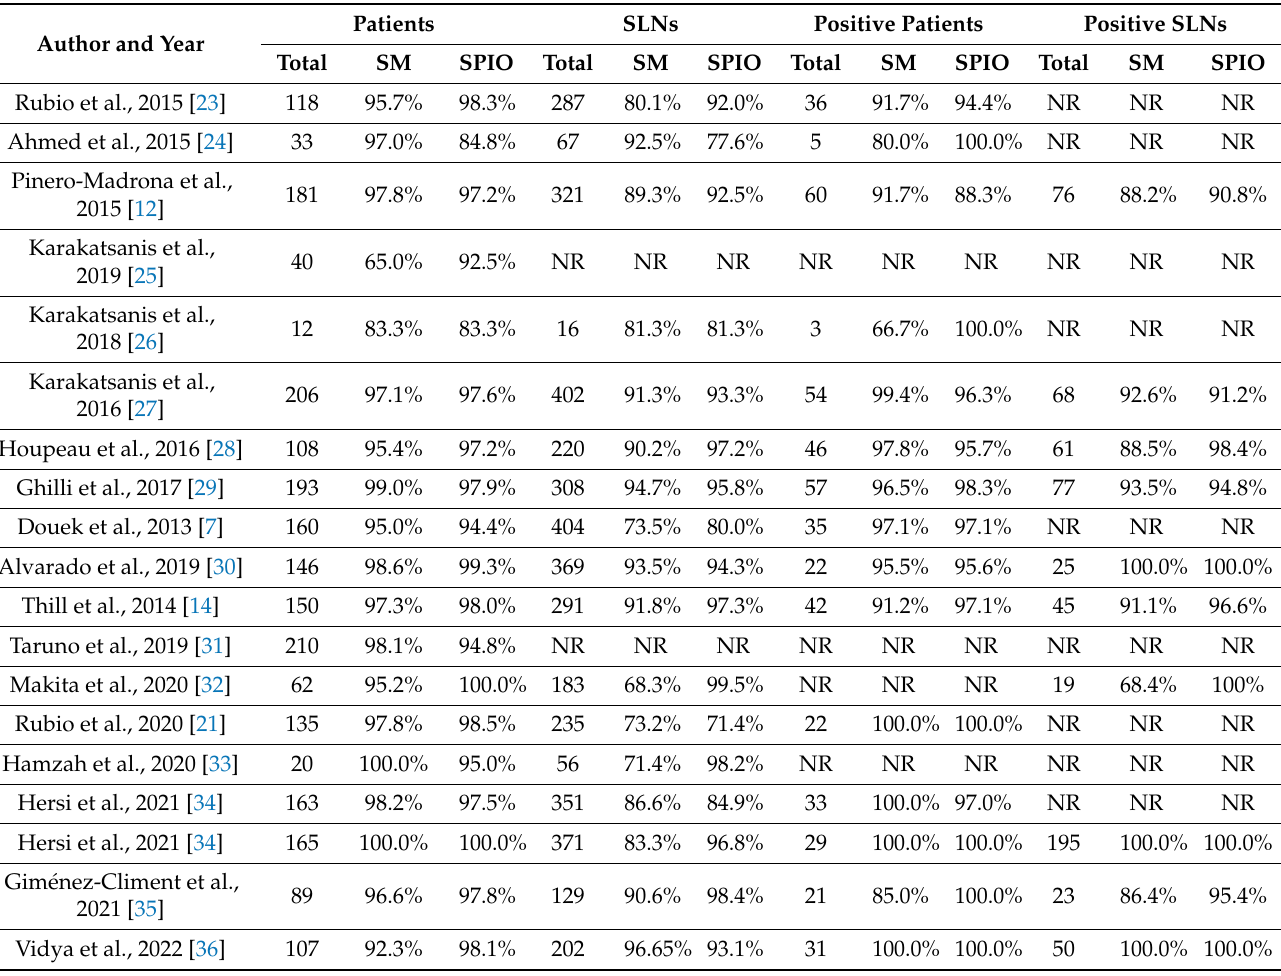
Calculated detection rate (%) of patients, SLNs, positive patients (patients with metastatic sentinel lymph nodes), and positive SLNs (metastatic sentinel lymph nodes) using two methods were listed as percentages.